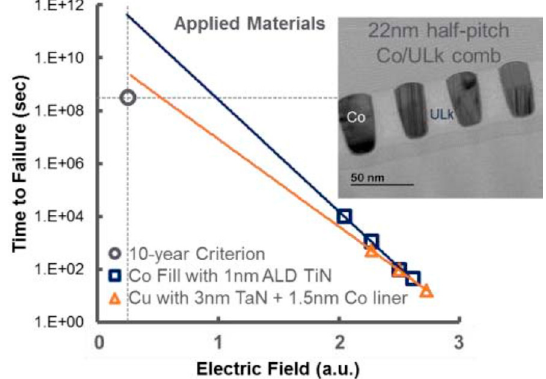
Figure 22. 22-nm half-pitch Co lines / ALD TiN liner compared to Cu [139].